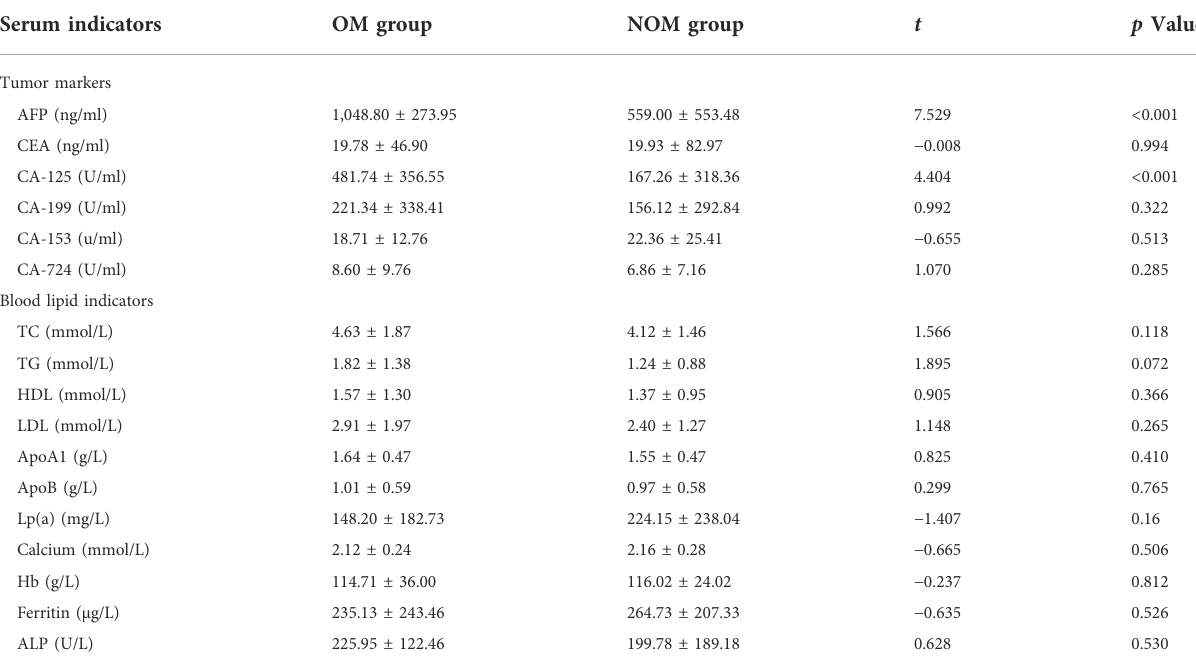
TABLE 2 The serum indicators of patients with metastases of primary liver cancer.